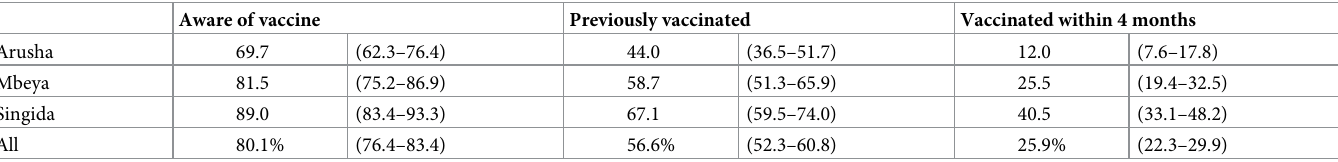
Table 2. Summary of three stages of ND vaccine adoption by region, (95% CI). Aware of vaccine Previously